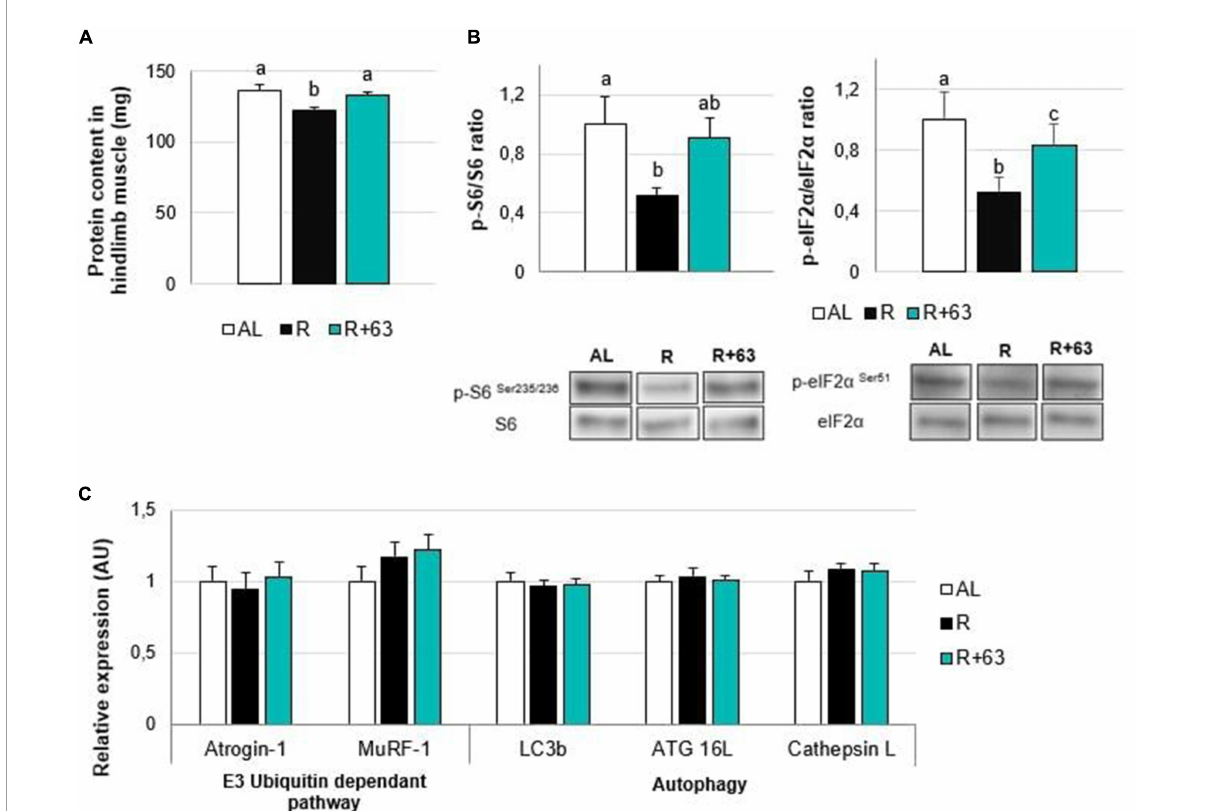
FIGURE6 Levels of protein, insulin pathway mediators, and proteolysis-related gene expression in the muscles of 18-month-old rats fed an ad libitum (AL) diet or a food-restricted (R) diet over a one-month period; one food-restricted group received a probiotic supplement – strain 63 (R+63). (A) Protein levels in hindlimb muscles (gastrocnemius, soleus, tibialis anterior, and extensor digitorum longus). (B) Levels of proteins involved in the AKT/mTOR/S6K pathway: ratio of phosphorylated proteins, p-S6 (Ser235/236), and p-eIF2 α (Ser51), to total proteins, S6 and eIF2 α . (C) Expression levels of muscle proteolysis genes, namely those related to the regulation of the ubiquitin-proteasome-dependent pathway (Atrogin-1 and MuRF-1) and autophagy pathway (Lc3b, ATG16L, and Cathepsin L). Values are means ± SEM. Differences in letters indicate a significant difference between groups (Kruskal–Wallis test and Dunn’s post hoc test, p ≤ 0.05, n = 61